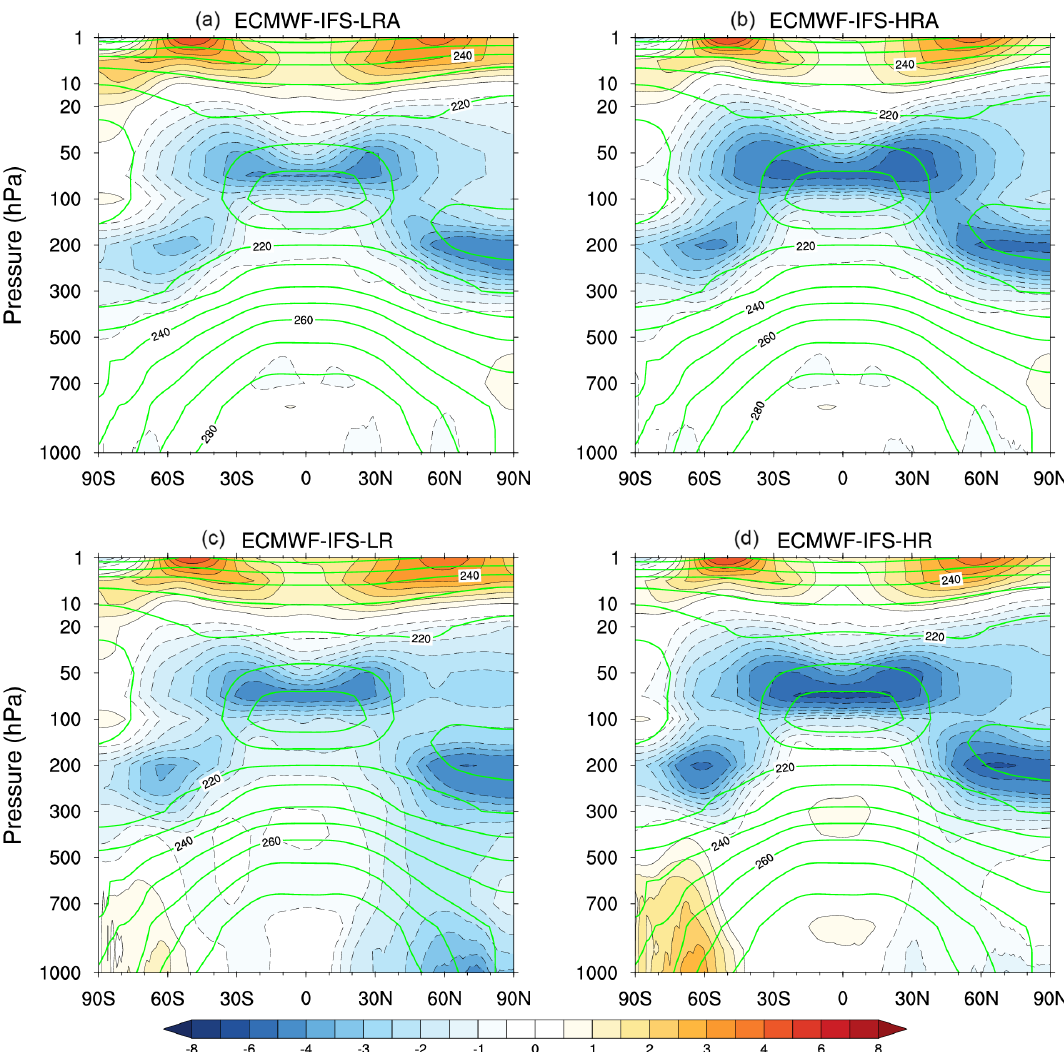
Figure 10. Mean bias in zonal-mean temperature in (a–b) highresSST-present and (c–d) hist-1950 relative to ERA-Interim for the period 1981–2010 (shaded) and the climatological mean from ERA-Interim